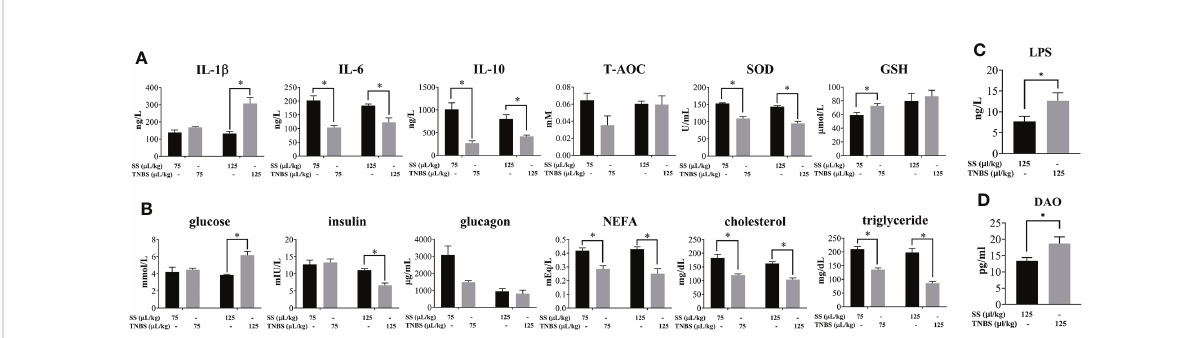
FIGURE 4 The effect of TNBS on the plasma in fl ammation, oxidative damage and glucolipid metabolism. (A) Plasma in fl ammatory cytokines, and T-AOC, SOD and GSH activity. (B) Plasma concentration of glucose, insulin, glucagon, NEFA, cholesterol and triglyceride. (C) Plasma concentration of LPS